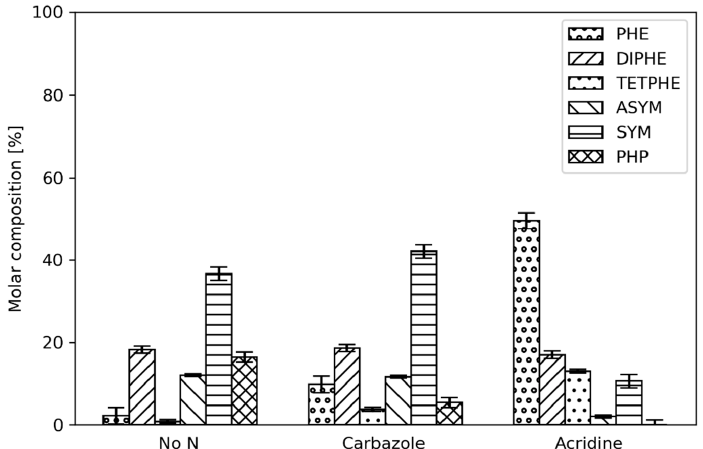
Figure 4. Phenanthrene product distribution with 1.2 mmol/dm 3 organic nitrogen (carbazole or acridine) present in the reactant feed at a reactor temperature of 300 °C.